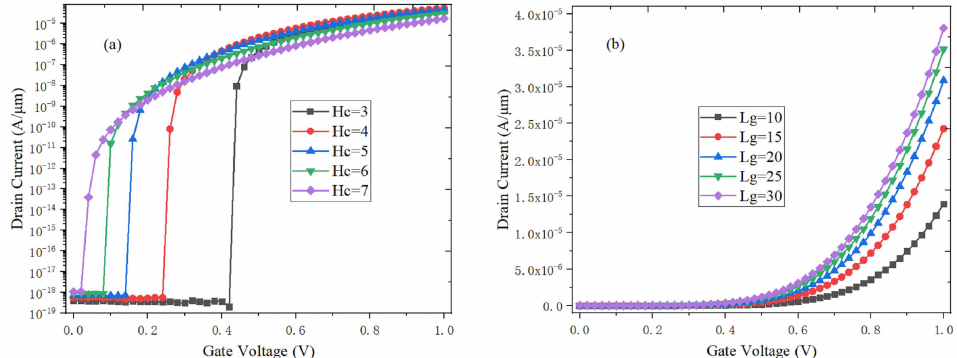
Figure 6. E ff ect of device parameters on the transfer characteristics of H-DLTFET ( a ) channel thickness Hc , ( b ) channel length Lg .